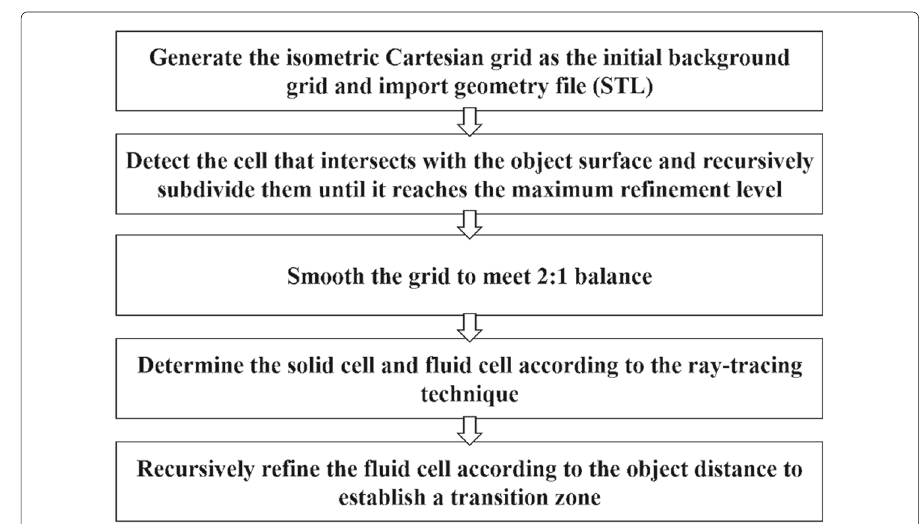
Fig. 2 The overall framework of the grid generation process in